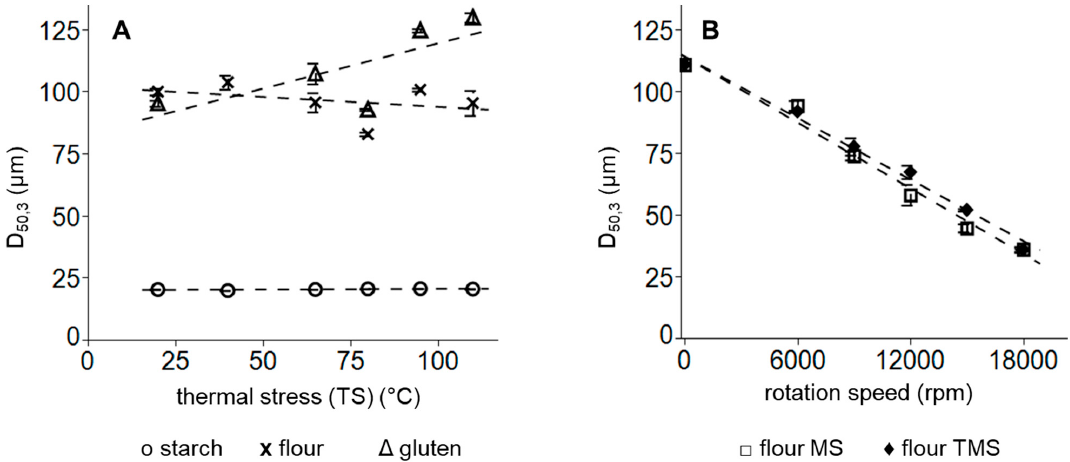
Figure 2. Mean particle size distribution after ( A ) exclusively thermal treatment of flour x, starch O and gluten Δ and ( B ) after mechanical treatment with thermal stress (TMS) ♦ or without thermal stress (MS) ≤ of wheat flours. Error bars represent standard deviations; n = 3.